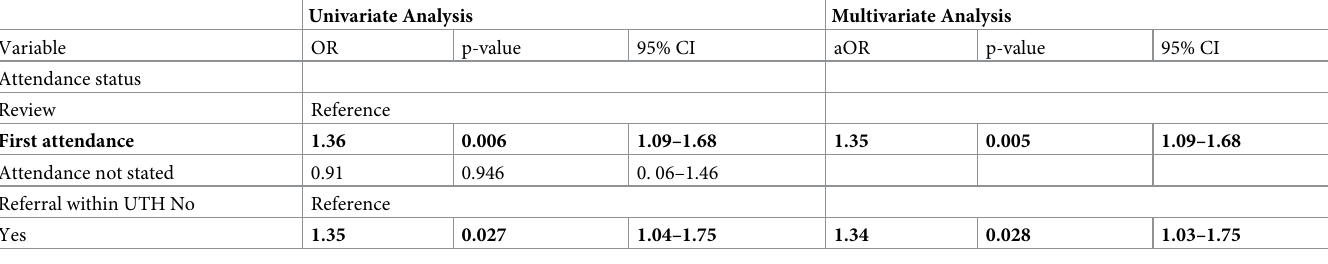
Table 3. Univariate and multivariate logistic regression of inappropriate referrals among the different patient